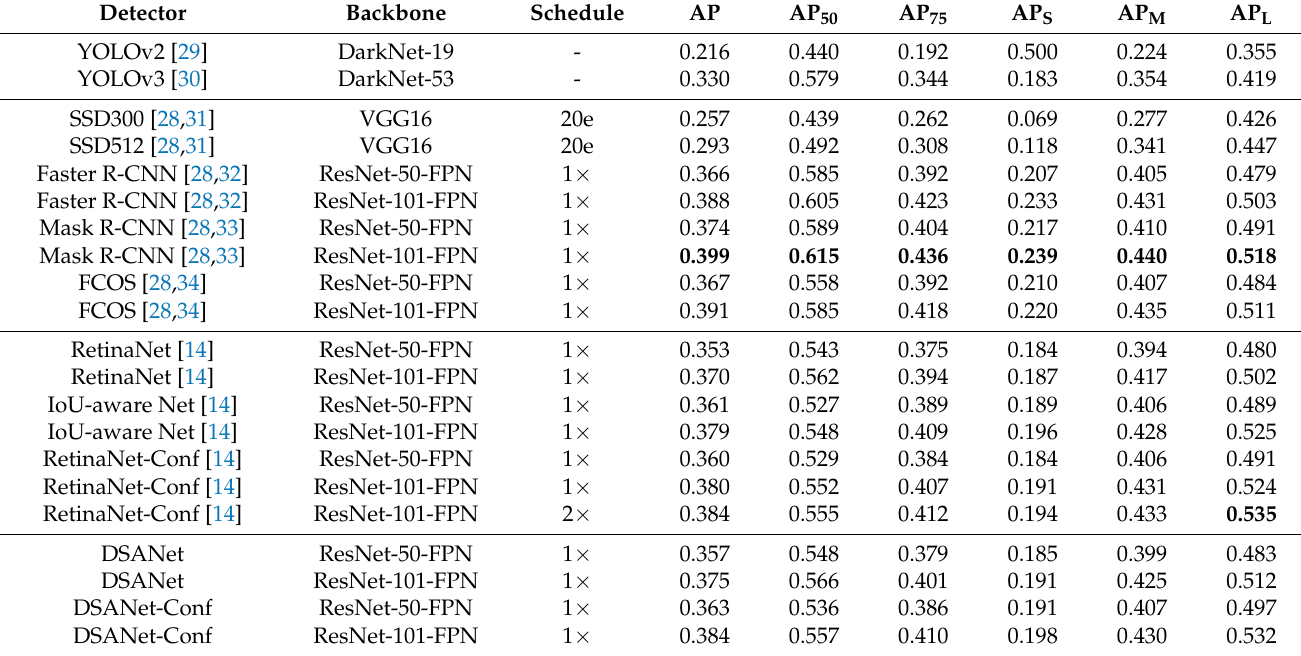
Table 7. Comparison of state-of-the-art detectors. The table is divided into four parts. The first part shows the performances of yolov2 and yolov3 from their published works. The second part shows the performances of state-of-the-art detection models, which are reported by MMDetection work. The third and fourth parts show the performances of improved RetinaNet, and these experiment results reported by our work. These bold data represent the start of the art